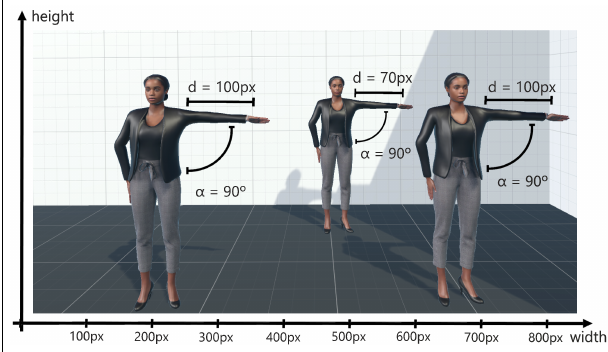
Figure 4. The same pose in different positions of a frame is represented by different values in pixels but equal values in angles, keeping the representa- tion